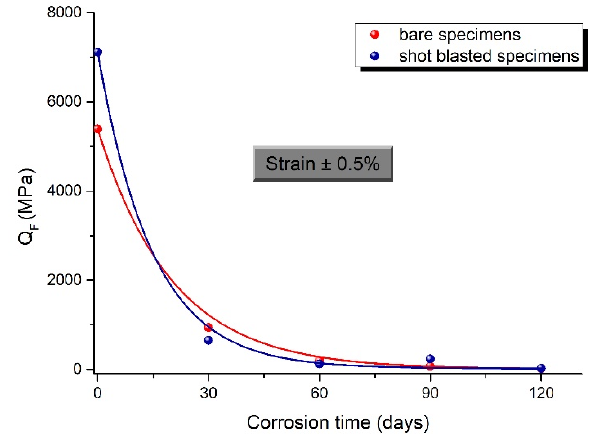
Figure 10. Extracted fitting curves of fatigue damage indicator Q F as a function of corrosion exposure for imposed deformation ±0.5% for both groups of specimens.